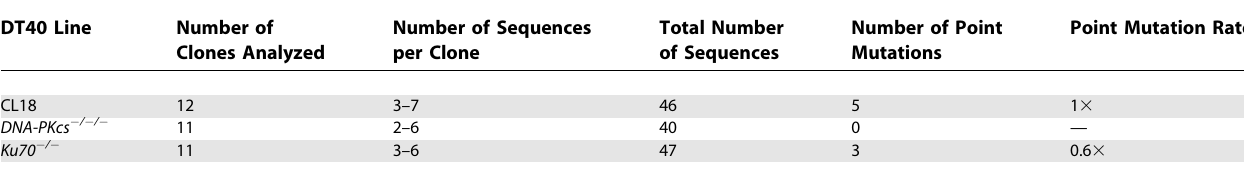
Table 3. Point Mutations Detected by Sequencing Random Clones from Experiment A DT40